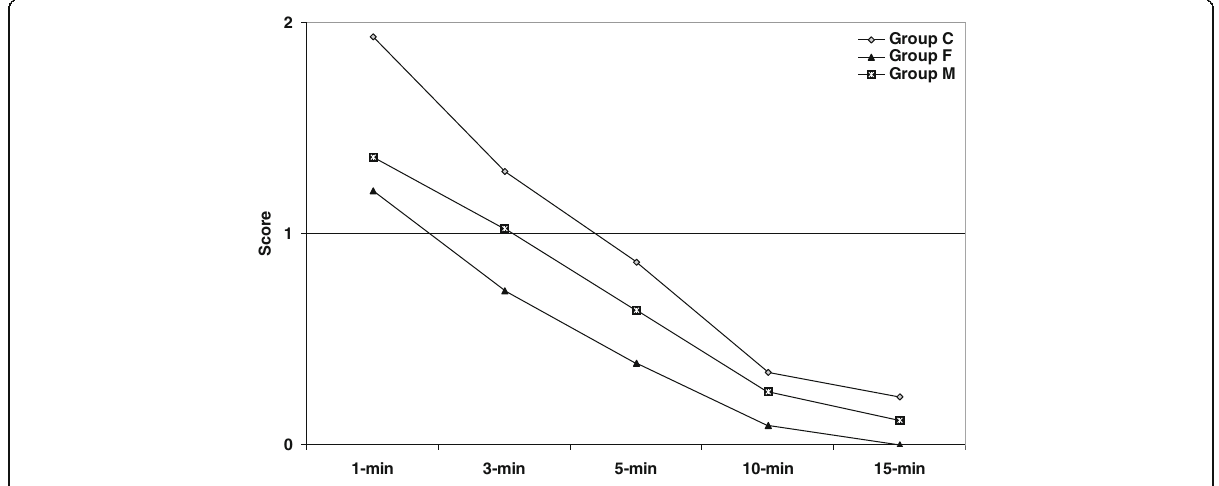
Fig. 1 Mean scoring of eyelid akinesia recorded in patients of studied group throughout 15 min after LAM injection